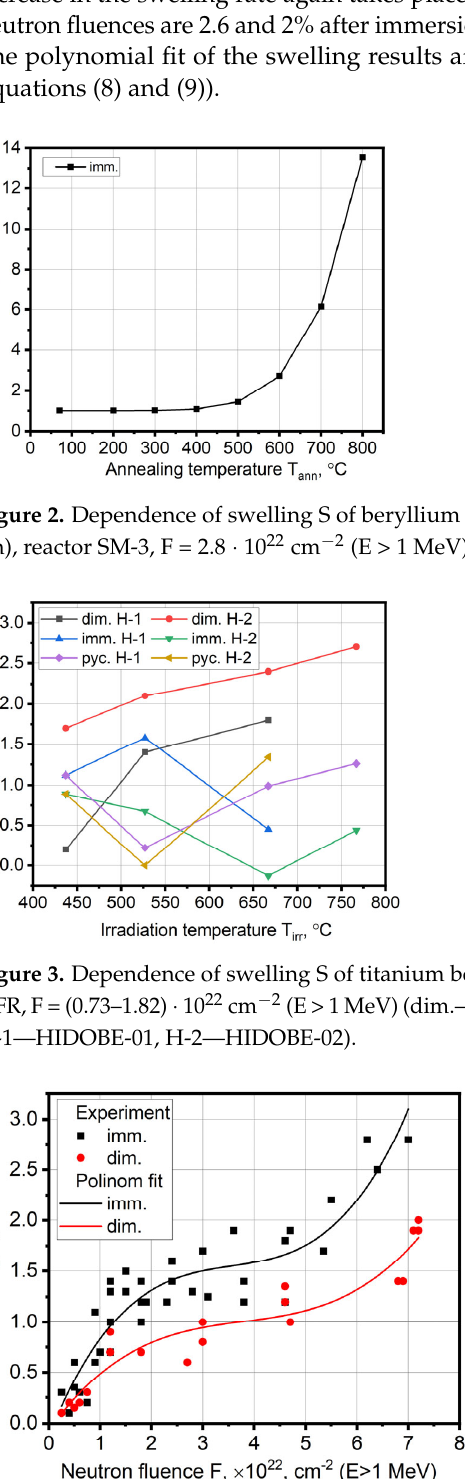
Figure 4. Dose dependence of swelling S of HE ‐ 56 beryllium grade, reactor SM ‐ 3, T irr = 70° С , F = F = (0.25–7.7) · 10 22 cm − 2 (E > 1 MeV) (imm.—immersion, (0.25–7.7) ∙ 10 22 cm − 2 (E > 1 MeV) (imm.—immersion, dim.—dimension).